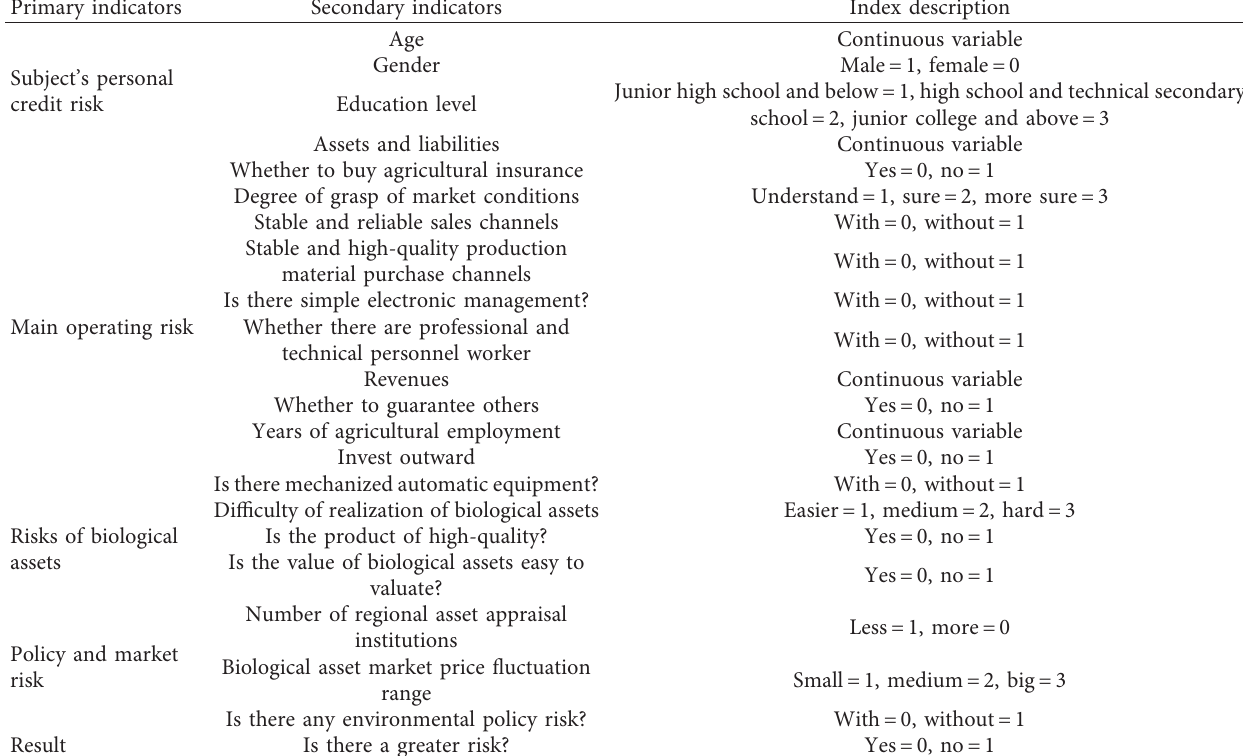
Table 2: Variable definition and descriptive